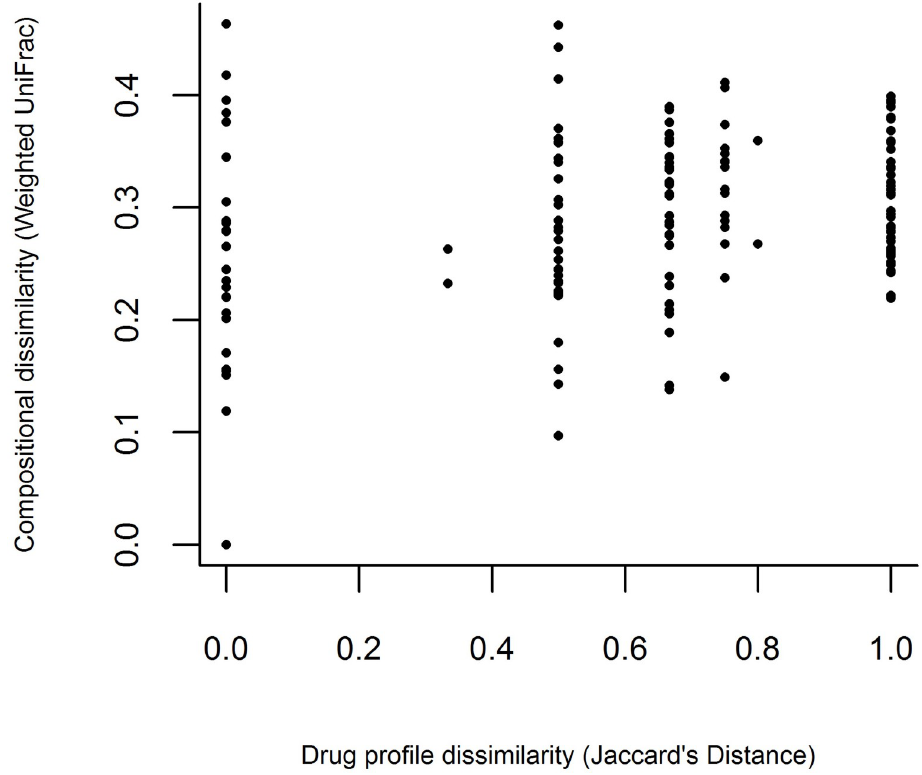
Fig 3. To test for differences in beta-diversity between groups the Jaccard distance metric was used. The unweighted Unifrac compositional dissimilarity was plotted against the Jaccard distances to demonstrate the drug profile